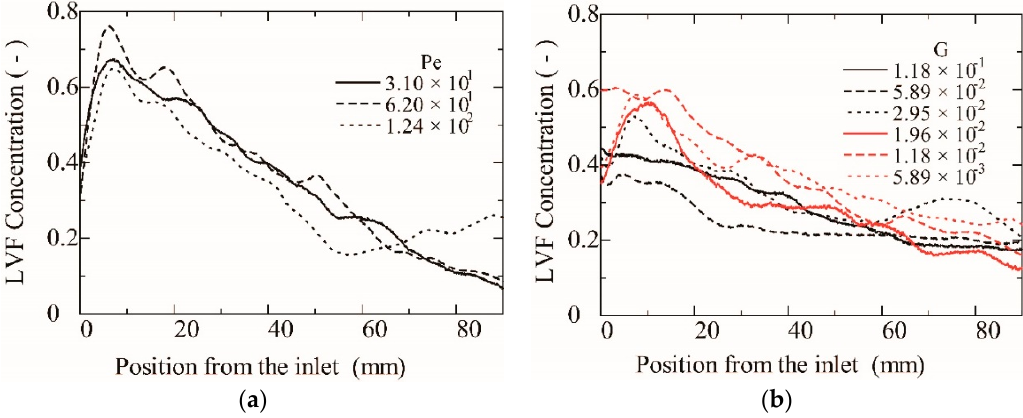
Figure 5. Concentration profiles in a flow direction ( a ) without gravity for three different Péclet numbers and ( b ) with gravity at various gravity numbers. The distance from the inlet in a flow direction is represented on the horizontal axis.